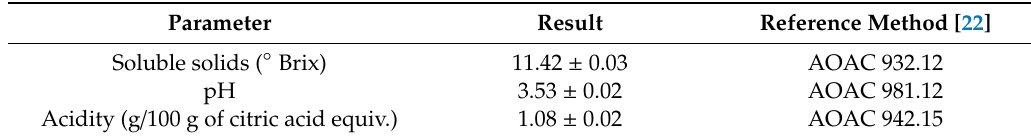
Table 1. Soluble solids ( ◦ Brix), pH and acidity